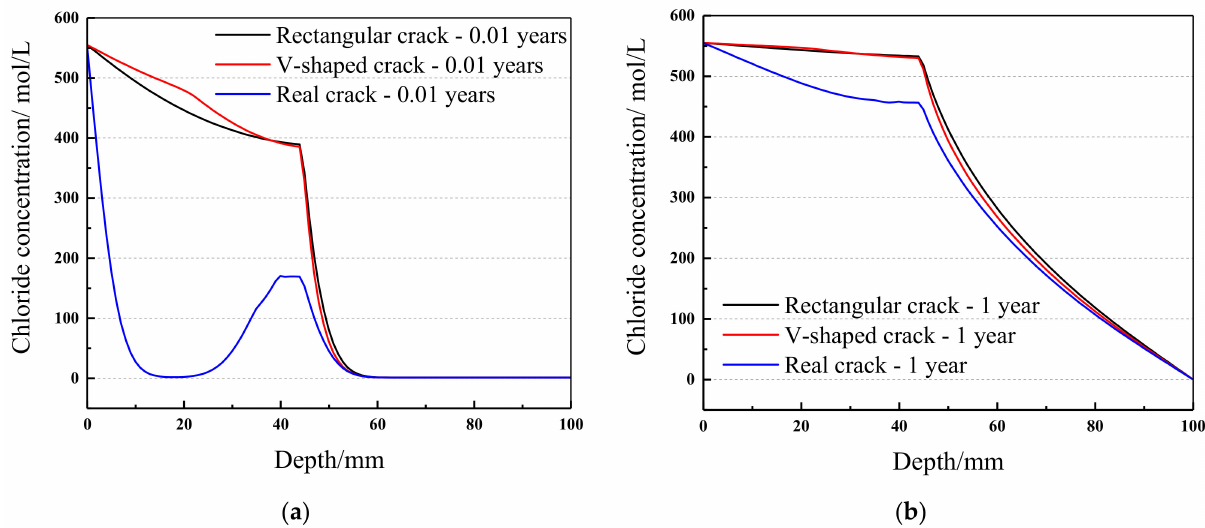
Figure 10. The chloride concentrations at the height of 25 mm in cracked concrete: ( a ) at the immersion age of 0.01 years; ( b ) at the immersion age of one